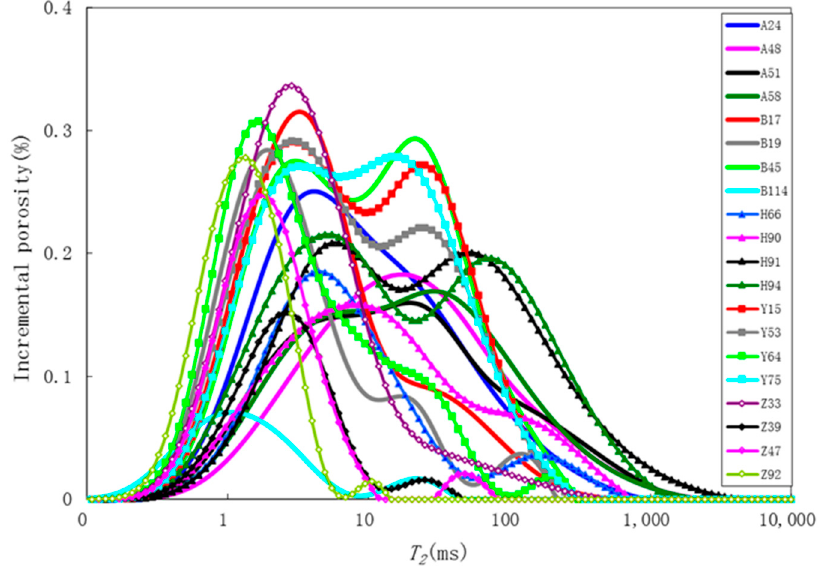
Figure 1. The types and distributions of minerals in the core plugs from five different zones.